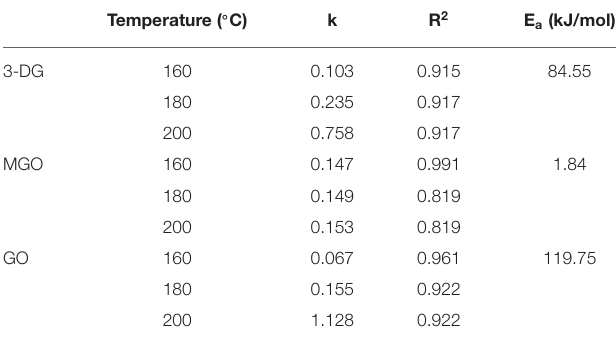
TABLE 2 | Parameter of kinetics of α -dicarbonyl compounds in heated model